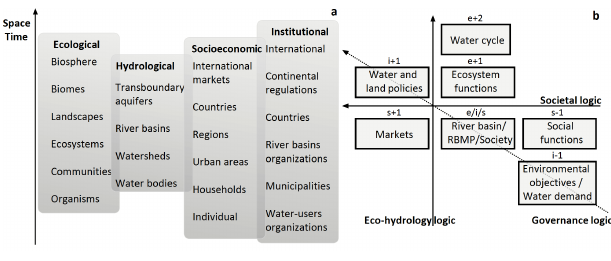
Fig. 2 . (a) Descriptive domains for a river basin. Adapted from Ewert et al. (2011); (b) Multiaxes holarchy for a river basin as a social-ecological system (SES). Adapted from Madrid and Giampietro (2015).